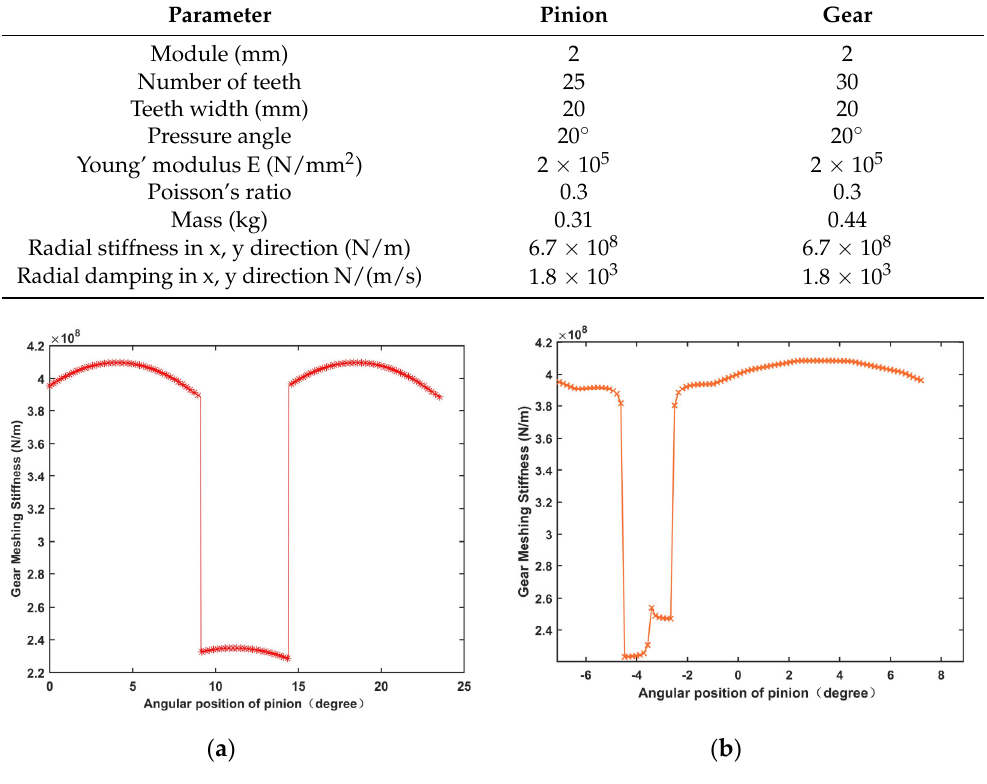
Figure 6. TVMS of gears: ( a ) The result of the current method; ( b ) KISSsoft result.